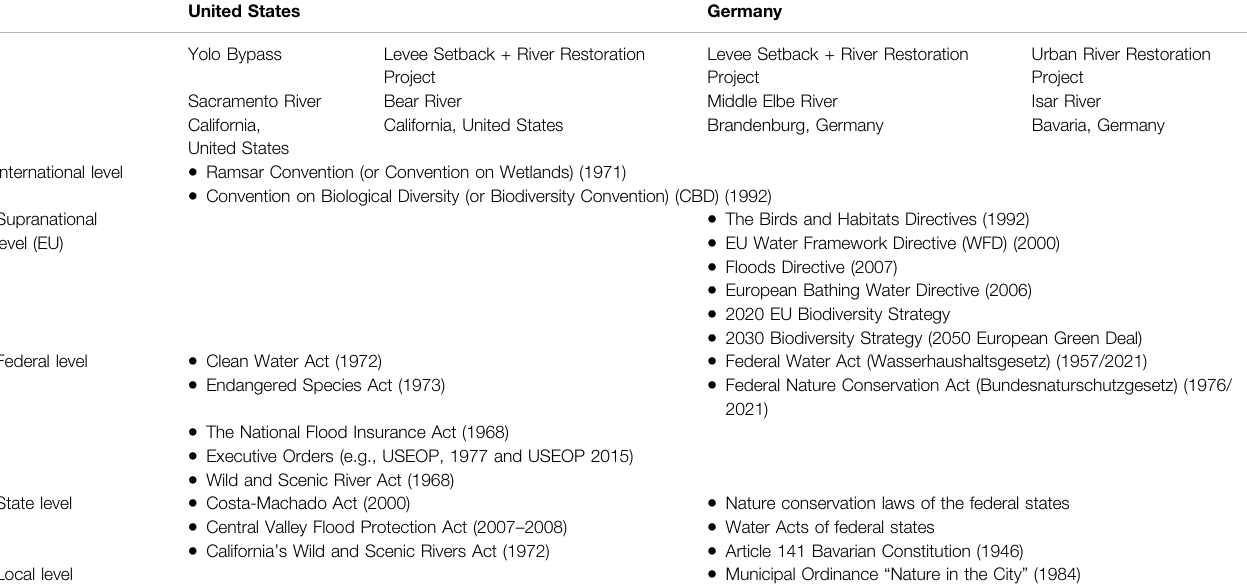
TABLE 1 | Main policies and legislation affecting the different case studies. Policies at a state and local level affecting the case studies are discussed in Section 4